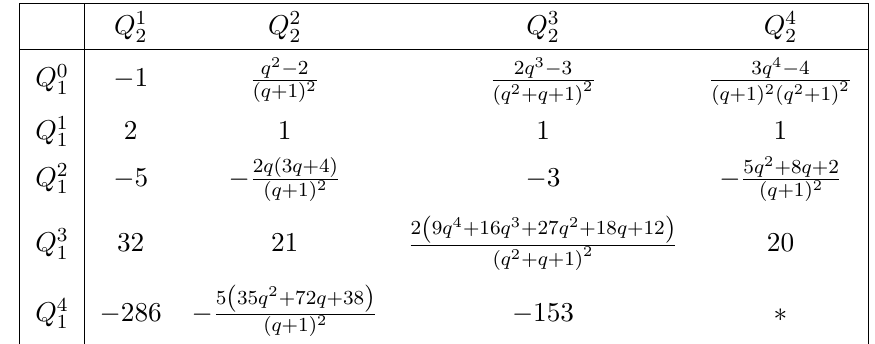
Table 1 . 1-pt correlators for X 4 that compute disk invariants in the q ! 1 limit. The two independent q -periods F F = (cid:11) ( t + 3 t ) 2 with constants (cid:11) 4 1 2 4 ;cl Q and agrees with the q -period of the Calabi-Yau threefold X 2 correlators obtained from F